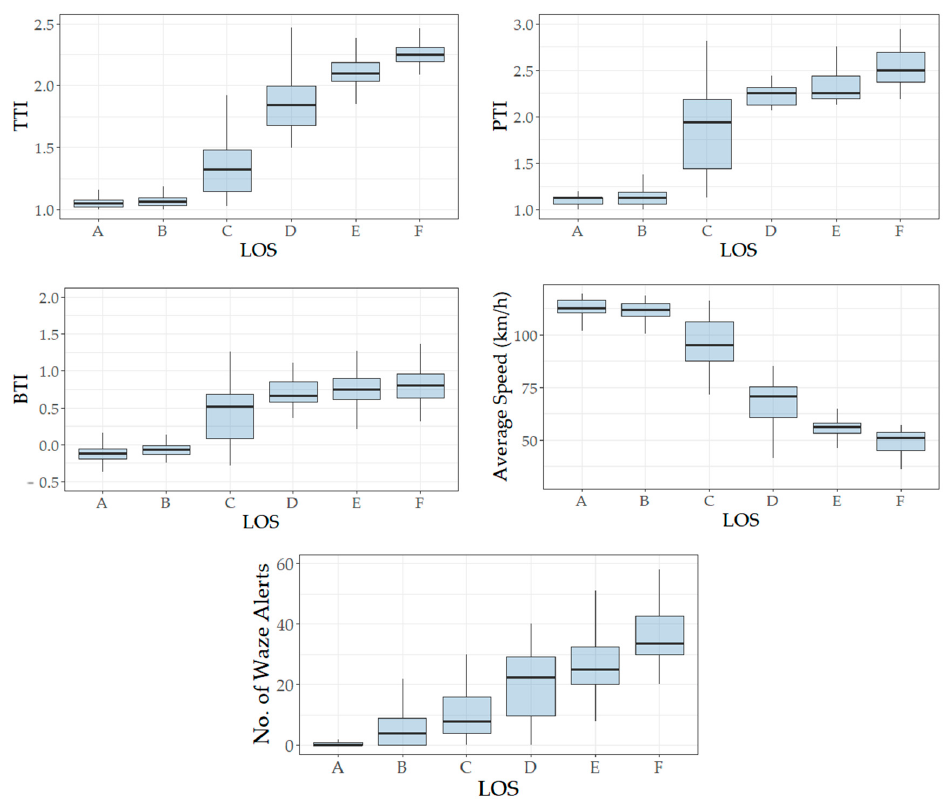
Figure 3. Boxplot of different measures in each LOS category.